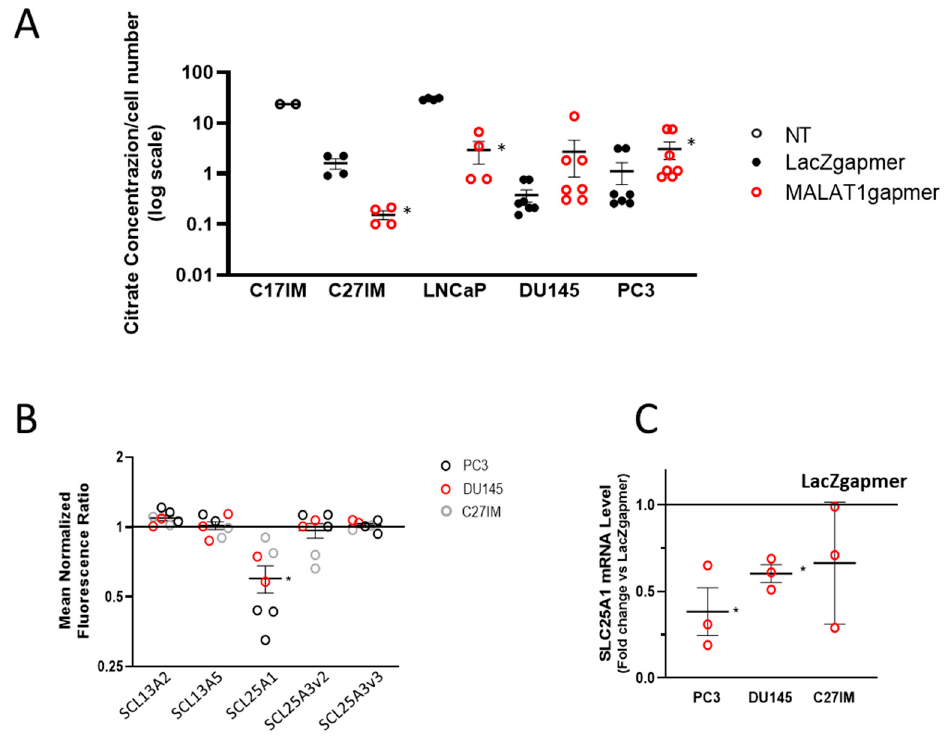
Figure 6. Evaluation of MALAT1 targeting on citrate production and expression of solute carrier transporters. ( A ) Citrate concentration analysis by colorimetric assay in the extracellular medium and normalized to cell number (10 6 cells) of normal/benign hyperplastic lesion-derived cells (C17IM) used as reference control or PCa cells (C27IM, LNCaP, DU145, and PC3) analyzed before/after MALAT1 targeting. Results are plotted as individual values ( n = 4–7) with mean ± SEM. ( B ) Citrate transporters genes emerging from transcriptomic analysis before/after MALAT1 depletion in C27IM, DU145, and PC3 cells. Transcript levels of SLC13A2, SLC13A5, SLC25A1, SLC13A3 variant 2 (SCL13A3v2), and SLC13A3 variant 3 (SCL13A3v3) are expressed as fold change vs. LacZgapmer (mean ± SEM are showed). ( C ) SLC25A1 expression level validated in different PCa cells (PC3, DU145, and C27IM) transfected with specific gapmer for MALAT1 or LacZ. Results are plotted as fold change vs. LacZgapmer (placed to 1 and depicted as a black line). Individual values ( n = 3) with mean ± SEM are shown. Non-parametric paired two-tailed Student’s t -test determined statistical significance. * p ≤ 0.05 MALAT1gapmer vs.